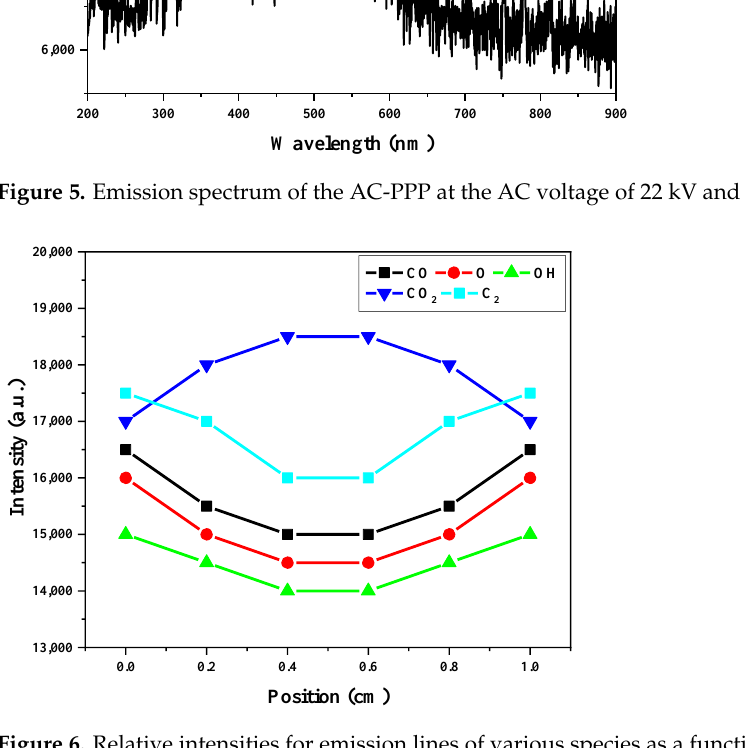
Figure 6. Relative intensities for emission lines of various species as a function of position at an AC voltage of 22 kV and 1 cm distance between electrodes.